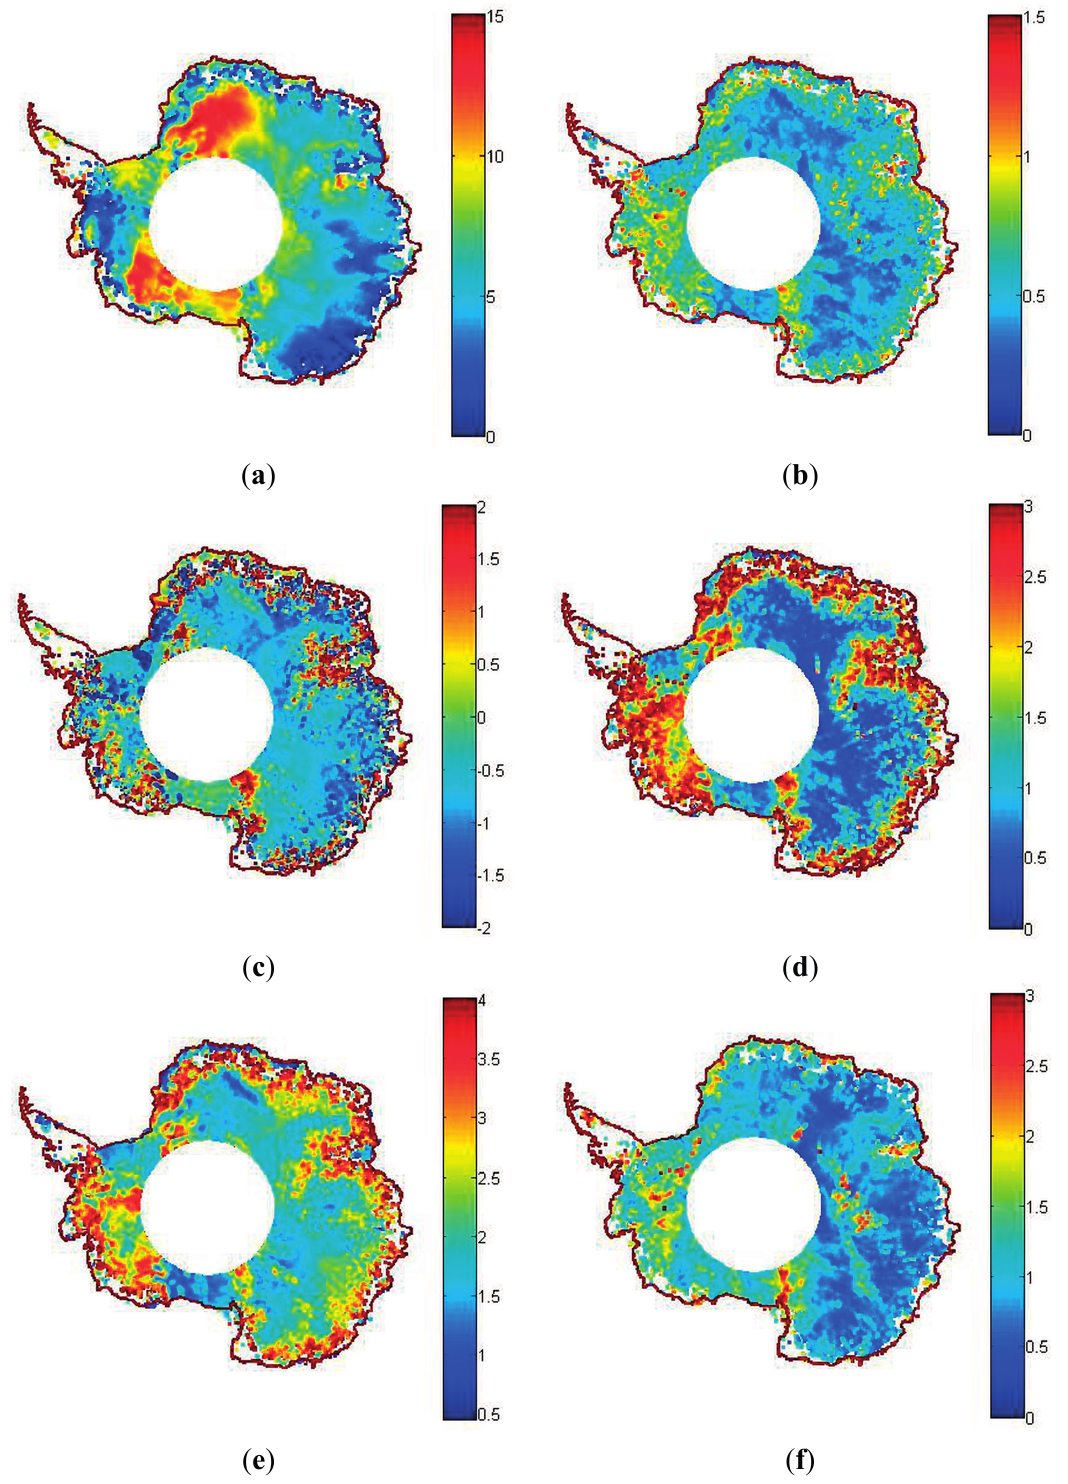
Figure 4. ( a – f ) Observations from ENVISAT: mean value for the backscatter coefficient in dB, mean value for the leading edge width in meters, mean value for the elevation difference in meters, std value for the backscatter in dB, std value for the leading edge width in meters, std value for the elevation difference in meters, respectively, from September 2003 to November